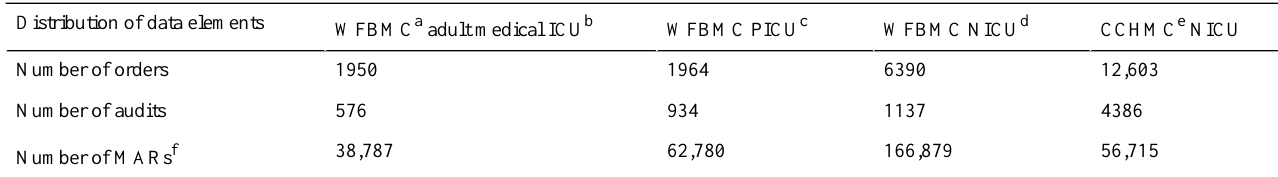
Table 1. Distribution of medication orders, audits, and medication administration records in the WFBMC ICUs compared to the CCHMC